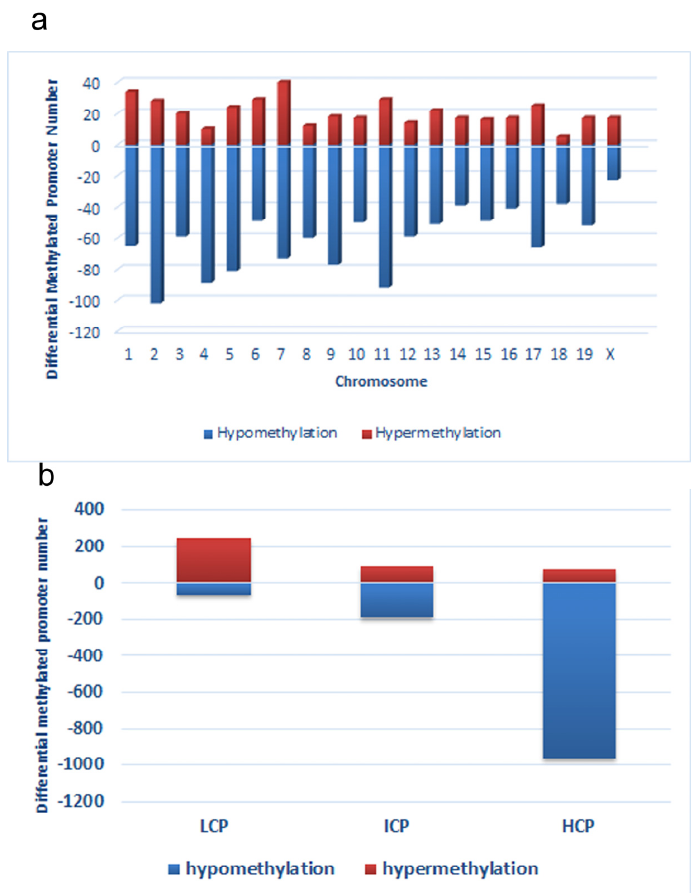
Figure 3. Distribution of differentially methylated promoters on chromosomes ( a ) and promoters with respect to the cytosine polyguanine (CpG) content ( b ), including high CpG promoters/regions (HCP), intermediate CpG promoters/regions (ICP), and low CpG promoters/regions (LCP)in low chromium diet-control diet (LC) group.